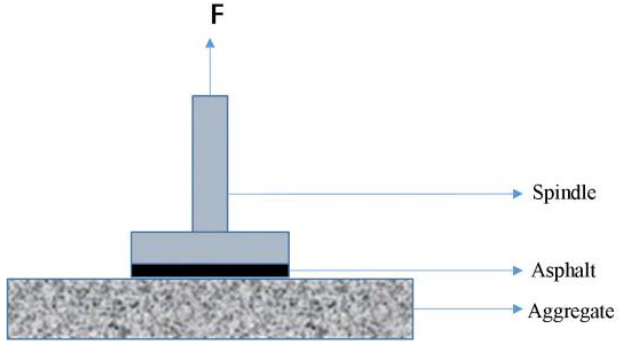
Figure 2. Schematic diagram of the pull-off test [35].